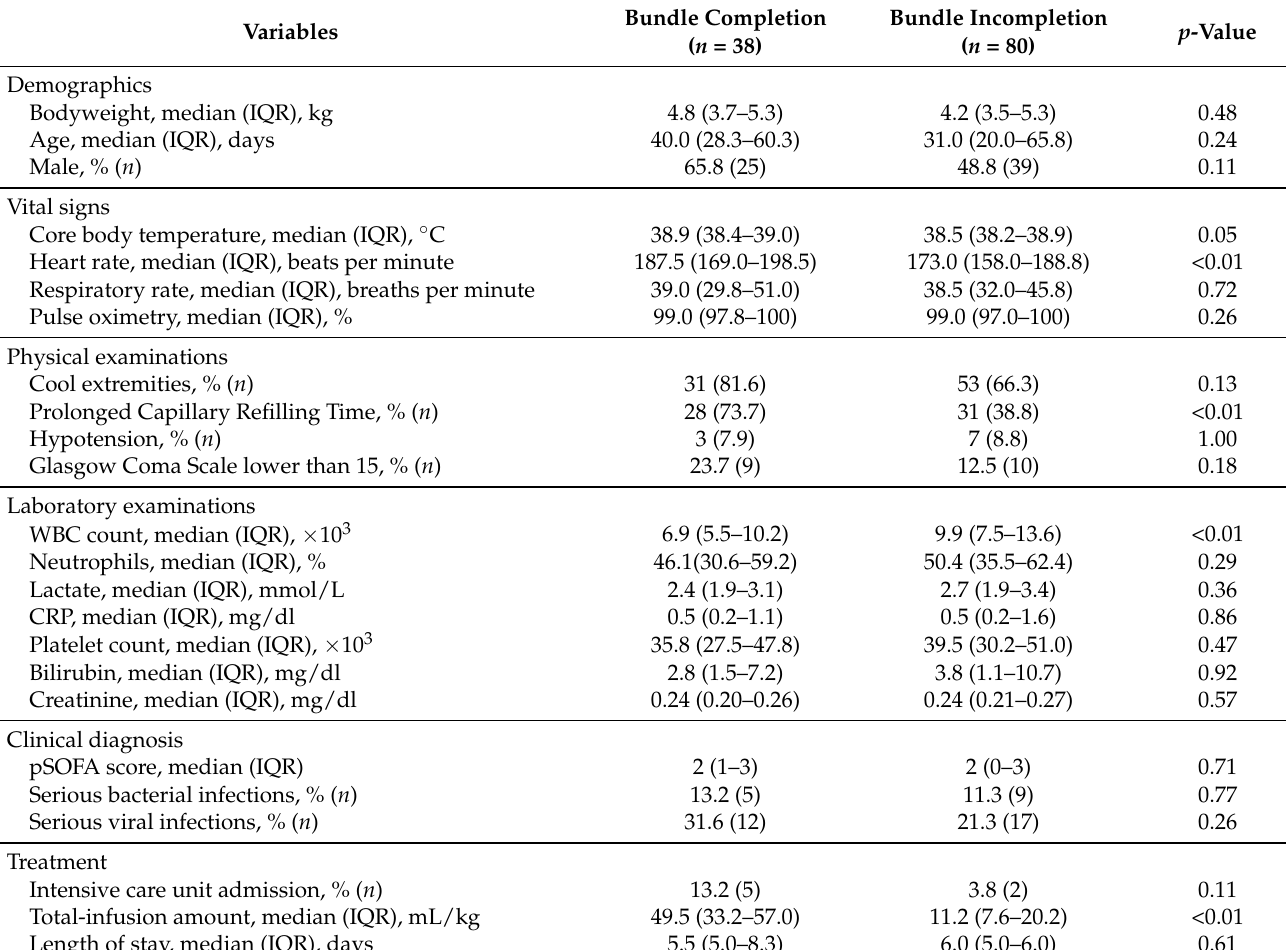
Table 2. Comparison between patients with bundle completion and the incompletion